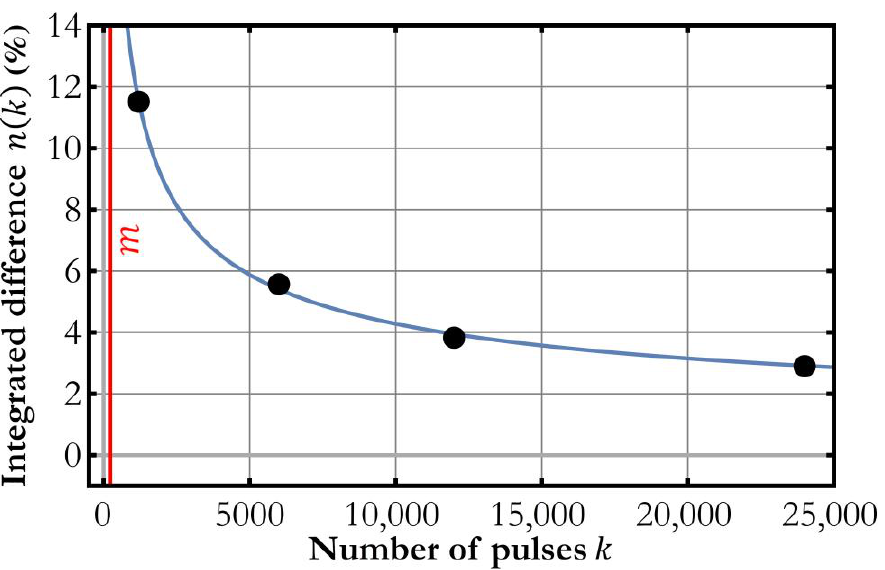
Figure 2. The dependence of the reconstructed 3D RXES plane’s noisiness on the number of XFEL shots recorded (black) calculated with Equation (4) and estimation based on a function ~1/√𝑘 (blue). Also shown is the methodological threshold 𝑚 (red) — minimum number of shots required for reconstruction, equal to the number of points in the incident spectra (in the present study equal to 225).